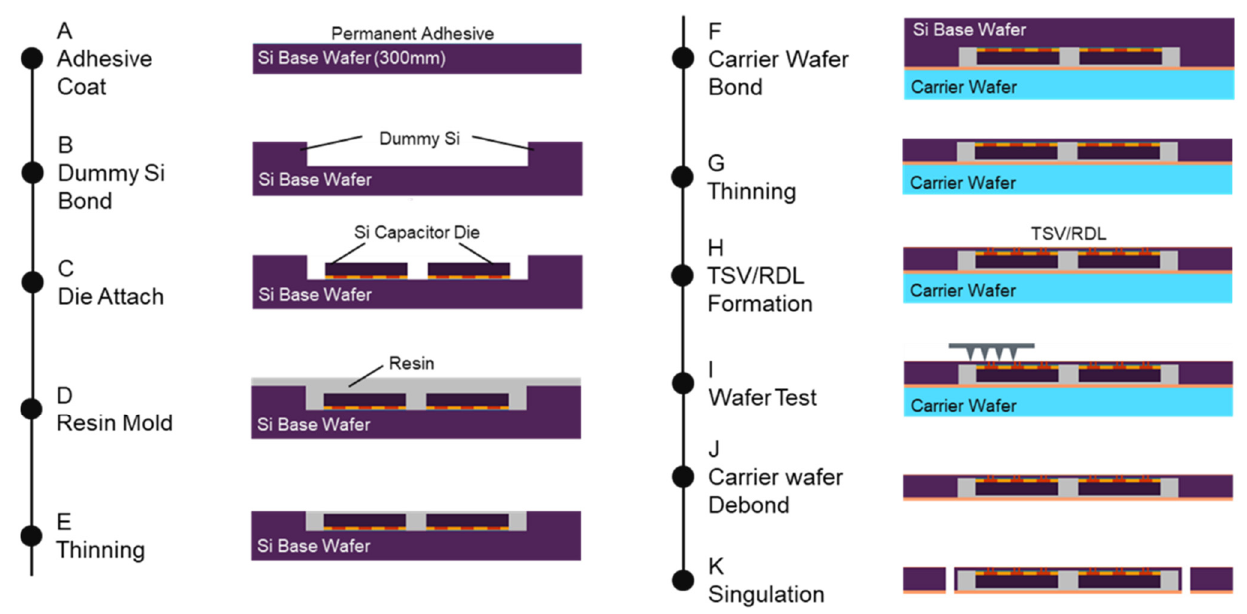
Figure 15. Bumpless COW process flow. Face-down die attachment and Front-side bumpless TSV interconnects are carried out.